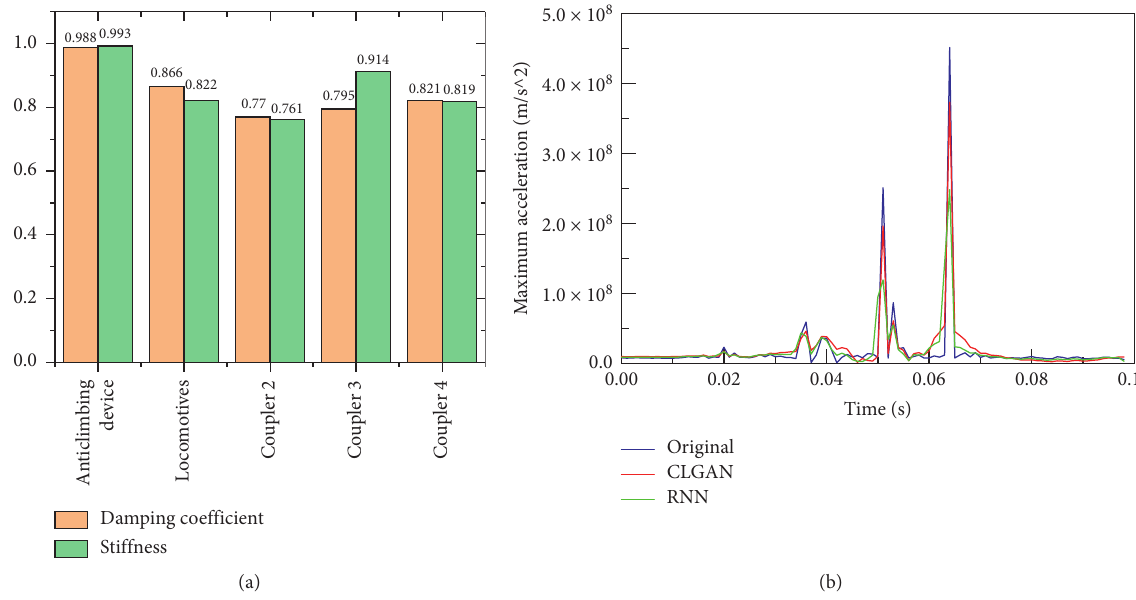
Figure 11: Estimation of CLGAN model. (a) Goodness of fit, R 2 , of nonlinear parameters. (b) Comparison of different methods.